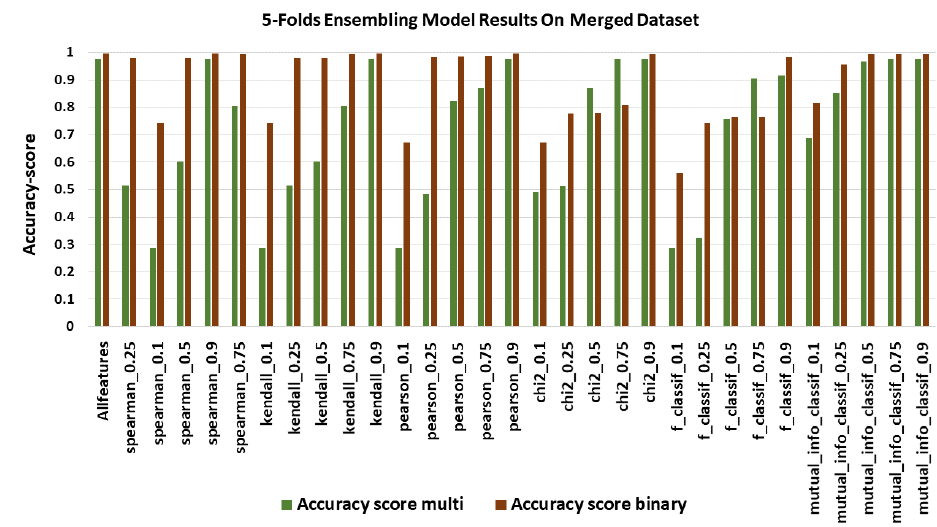
Figure 6. Accuracy using merged dataset.